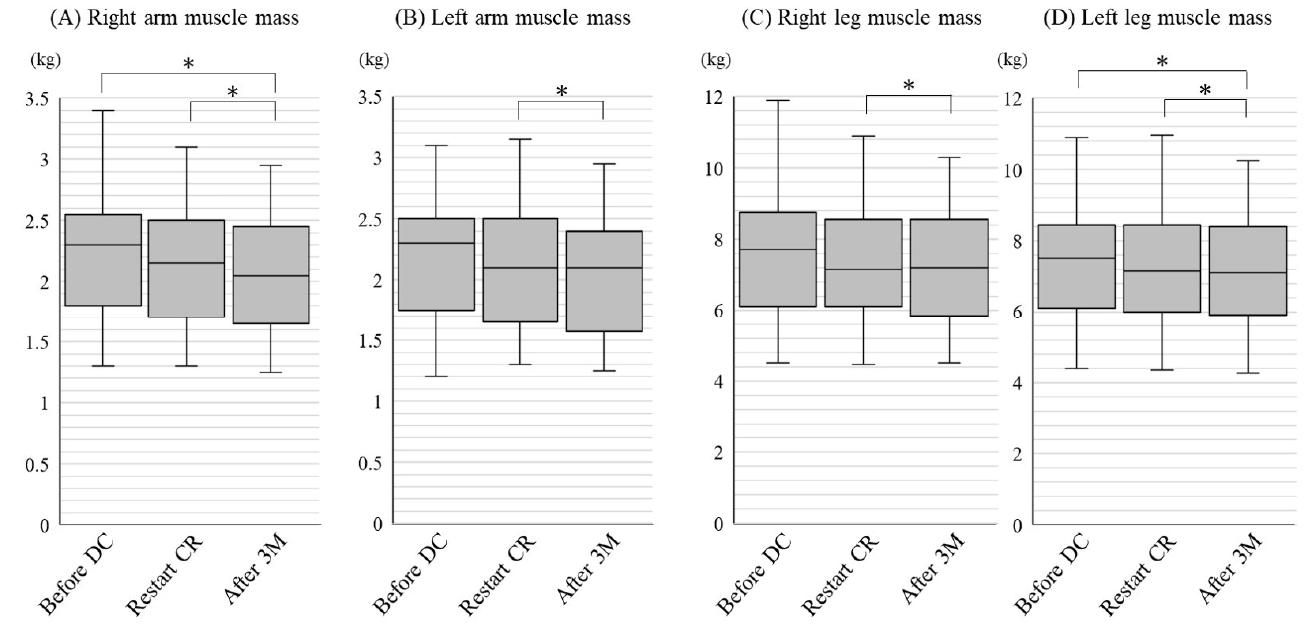
Figure 2. Changes in limb muscle mass before DC, at restart of CR and after 3 months. Limb muscle mass was investigated by a body composition analyzer. ( A ) right arm, ( B ) left arm, ( C ) right leg, ( D ) left leg muscle mass at each timing before discontinuation (DC), at restart of cardiac rehabilitation (CR), and after 3 months (M) of CR are shown. * indicates p < 0.05.